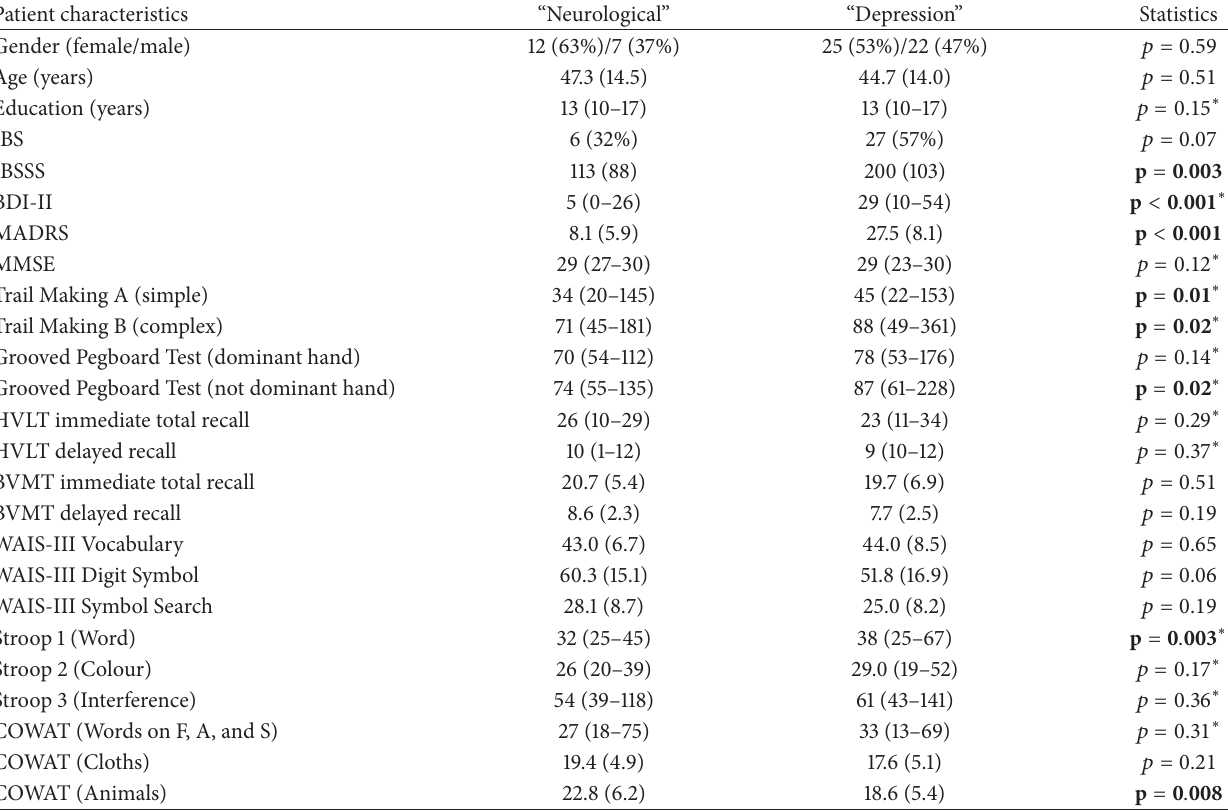
Table 1: Patient characteristics and comparisons between the “Neurological” and “Depression”